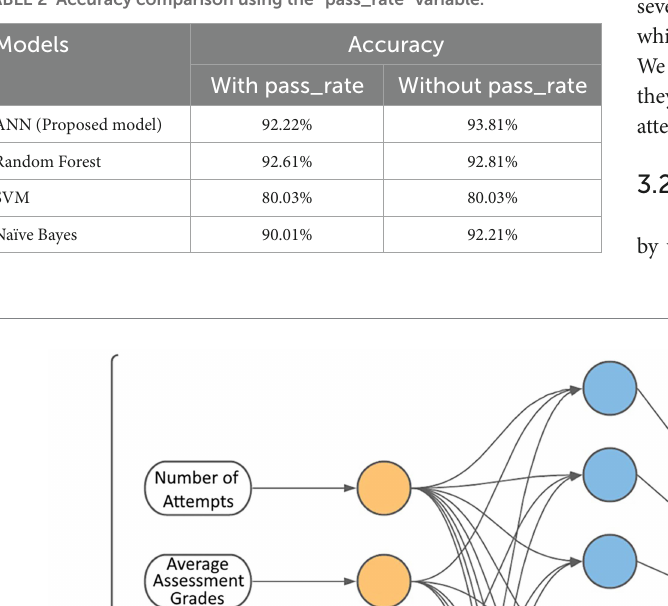
TABLE 2 Accuracy comparison using the “pass_rate” variable.